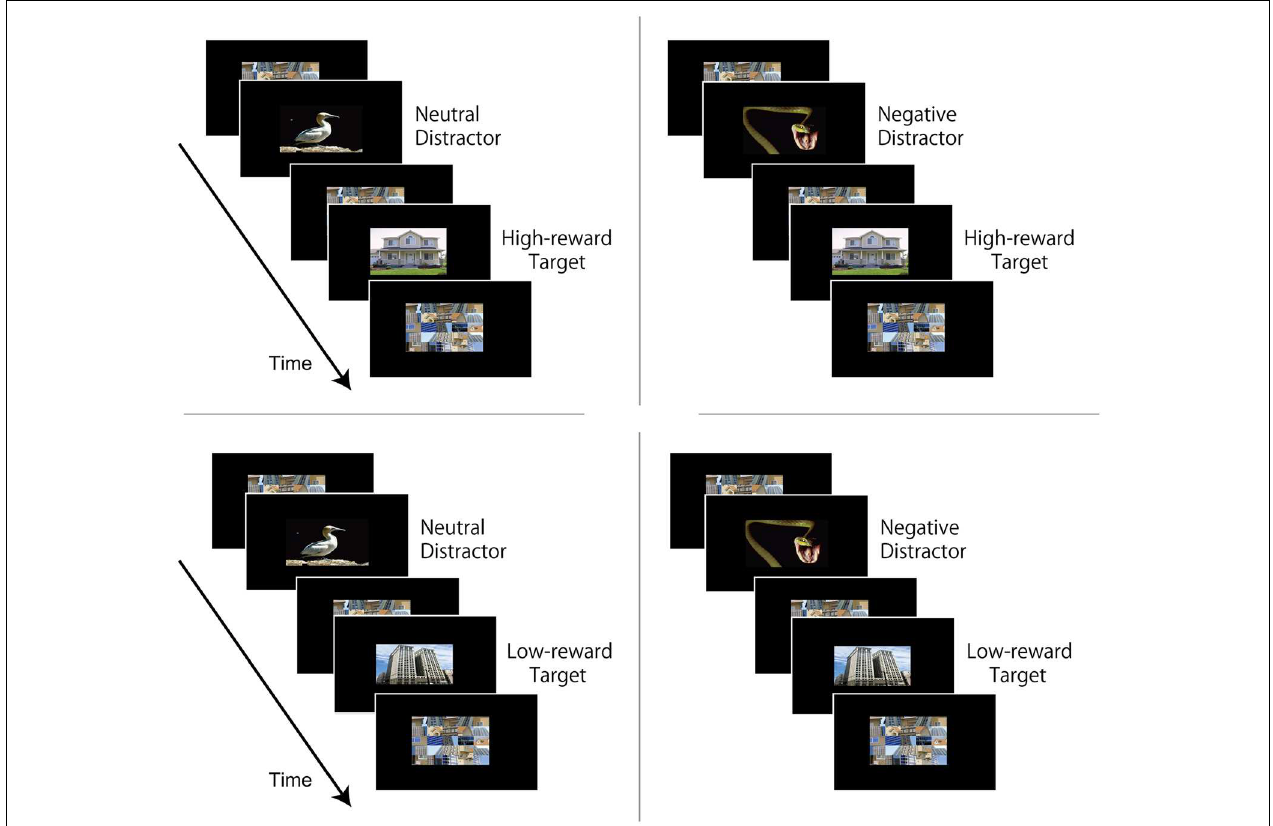
(e.g., “house”) or low-reward (e.g., “building”) in the learning phase always appeared two images after the critical distractor. The remaining 15 images were non-critical filler images presented in random order. Participants were instructed to ignore all images in the visual stream except the target image, and at the end of the visual stream they answered whether the target image was “house” or